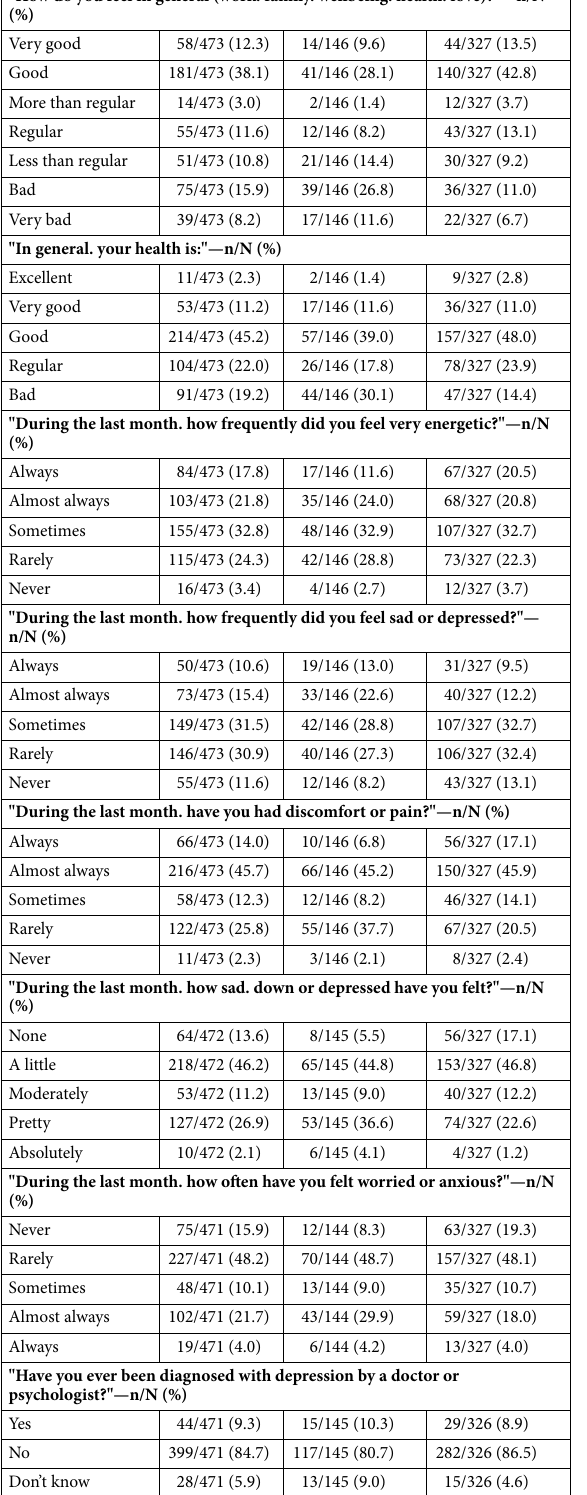
Table 4. Survey of quality of life and perception of